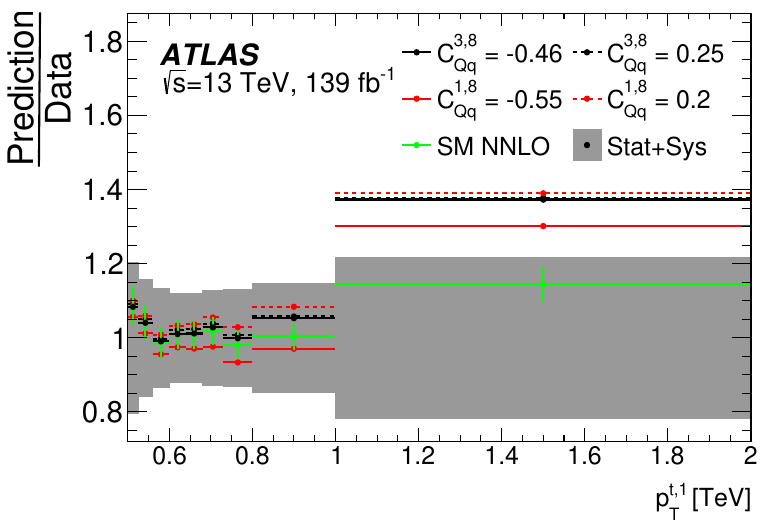
Figure 35 . The ratio of various SMEFT predictions that include non-zero Wilson coefficients to the data for the leading top-quark p t, 1 distribution. No uncertainties are included for these T calculations. The values of non-zero Wilson coefficients correspond approximately to the 95% CL limits obtained by this measurement. The SM NNLO calculations as obtained by the nominal Matrix settings is also shown. It includes the symmetrized scale